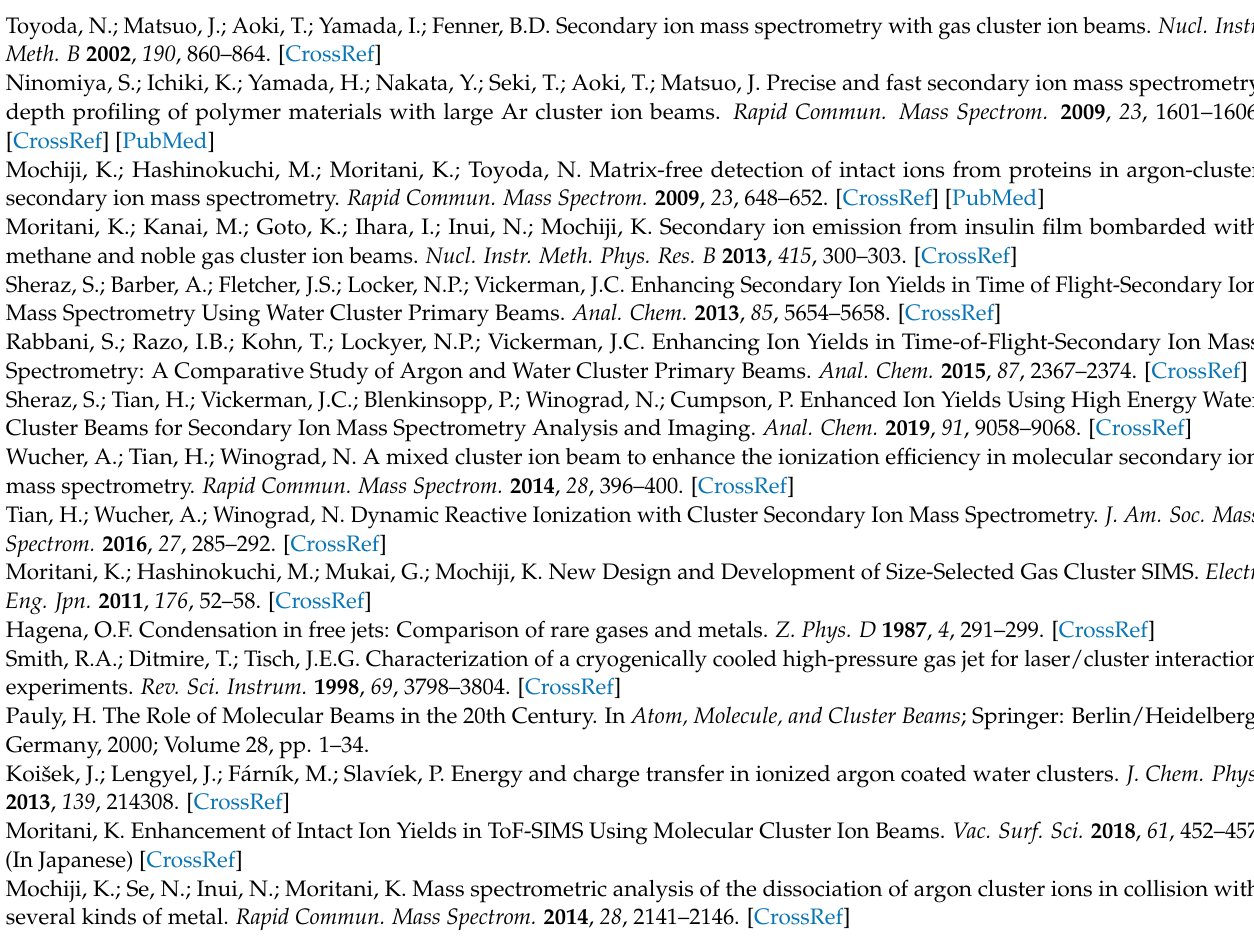
Figure A1. Size ( n ) distribution of water cluster ion beams generated by Ar and Ar/He carrier gases.